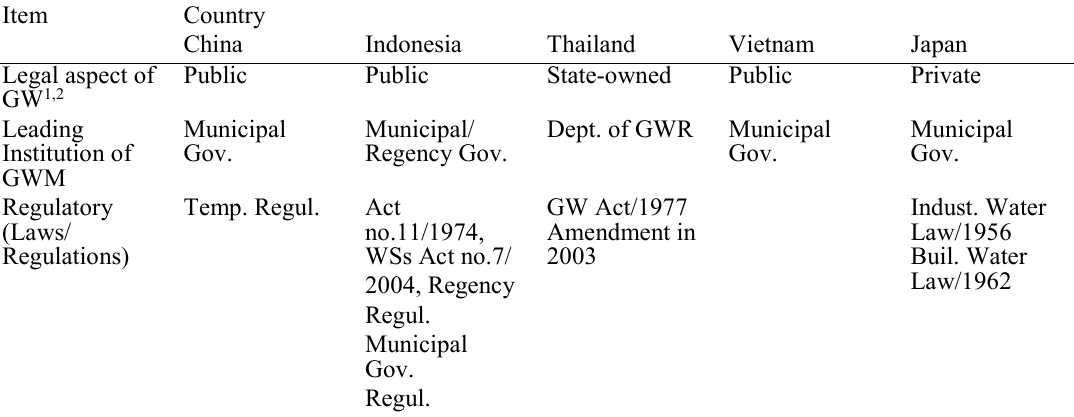
Table 1 Summary of the present state of regal aspect, reading institutions and regulatory of groundwater governance in Asian